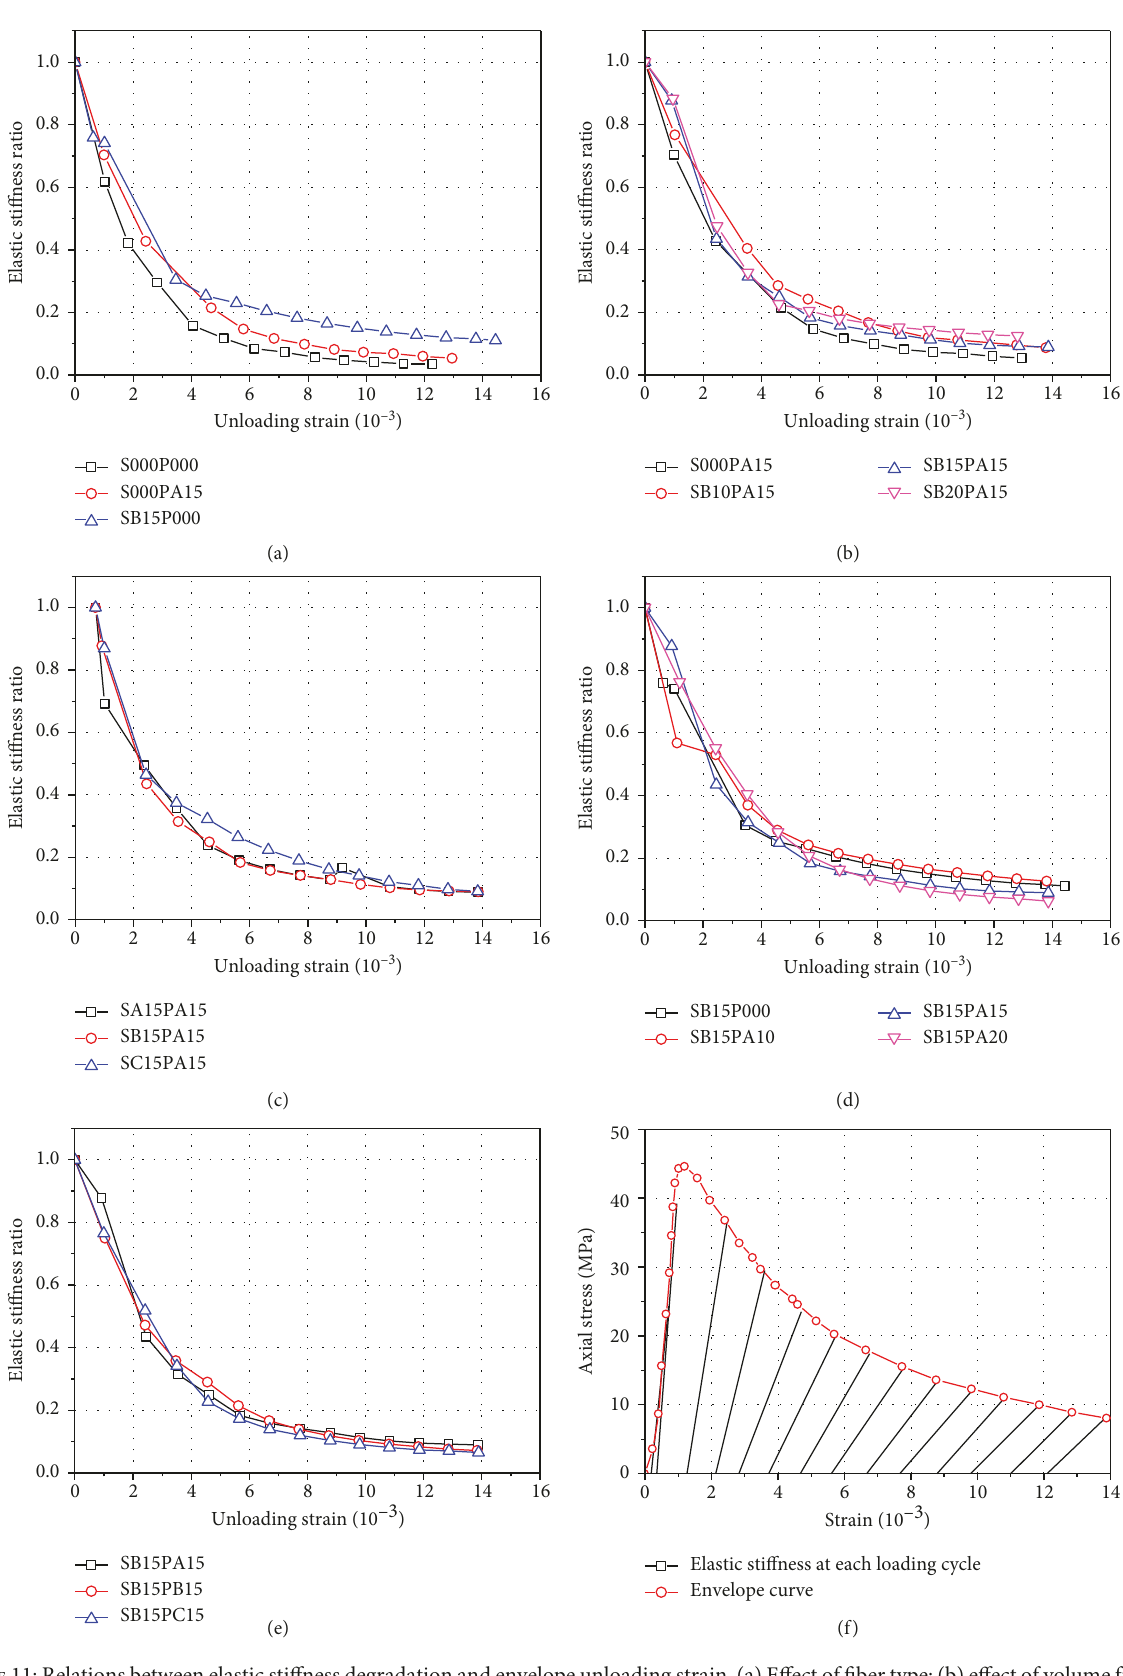
Figure 11: Relations between elastic stiffness degradation and envelope unloading strain. (a) Effect of fiber type; (b) effect of volume fraction of SF; (c) effect of aspect ratio of SF; (d) effect of volume fraction of PF; (e) effect of aspect ratio of PF; and (f) schematic diagram of typical elastic stiffness degradation process of